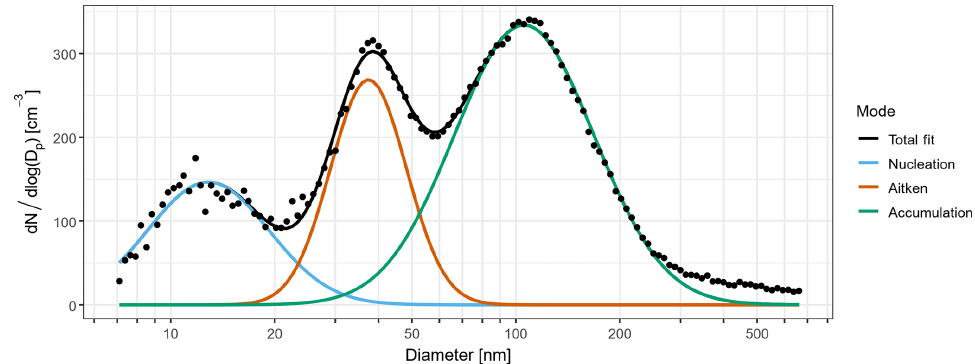
Figure 11. Mean number size distribution for sub-micron aerosol during two sampling periods influenced by continental Antarctic air masses. The coloured lines are fitted log-normal distributions representing contributions from nucleation (blue), Aitken (brown), and accumulation (green) mode aerosol to the observed total size distribution (black